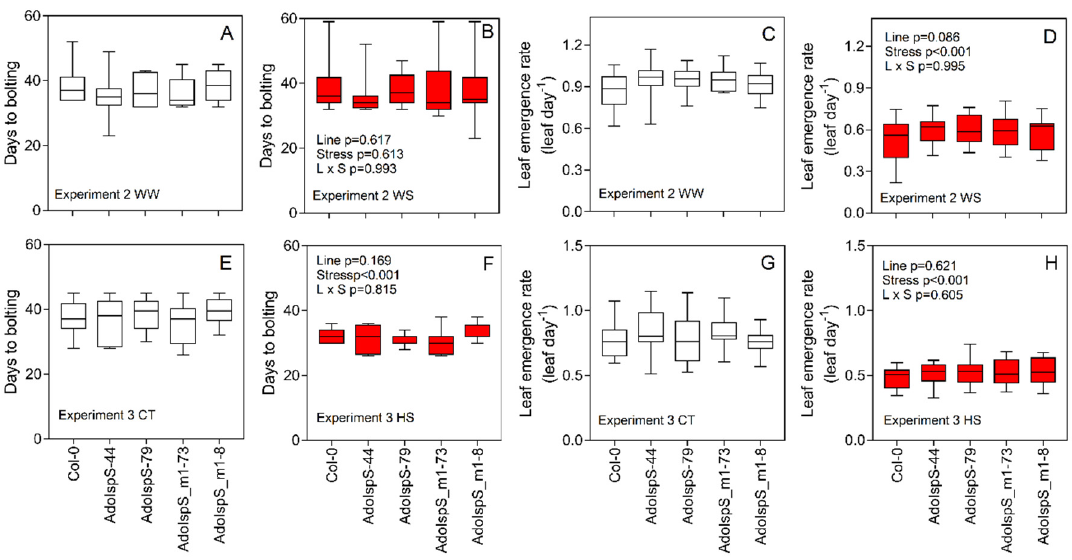
Figure 2. Days to bolting and the leaf emergence rate assessed in Experiment 2 ( A – D ) and 3 ( E – H ). For all the graphs, black bars represent the control (either WW or CT) conditions, whereas red bars represent plants subjected to stress (either WS or HS) ( n = 12). Data were analyzed with two-way ANOVA and the output is included in the graph. Means separation was carried out with Fisher’s test (since no differences are present between lines, the respective letters were omitted for simplicity).